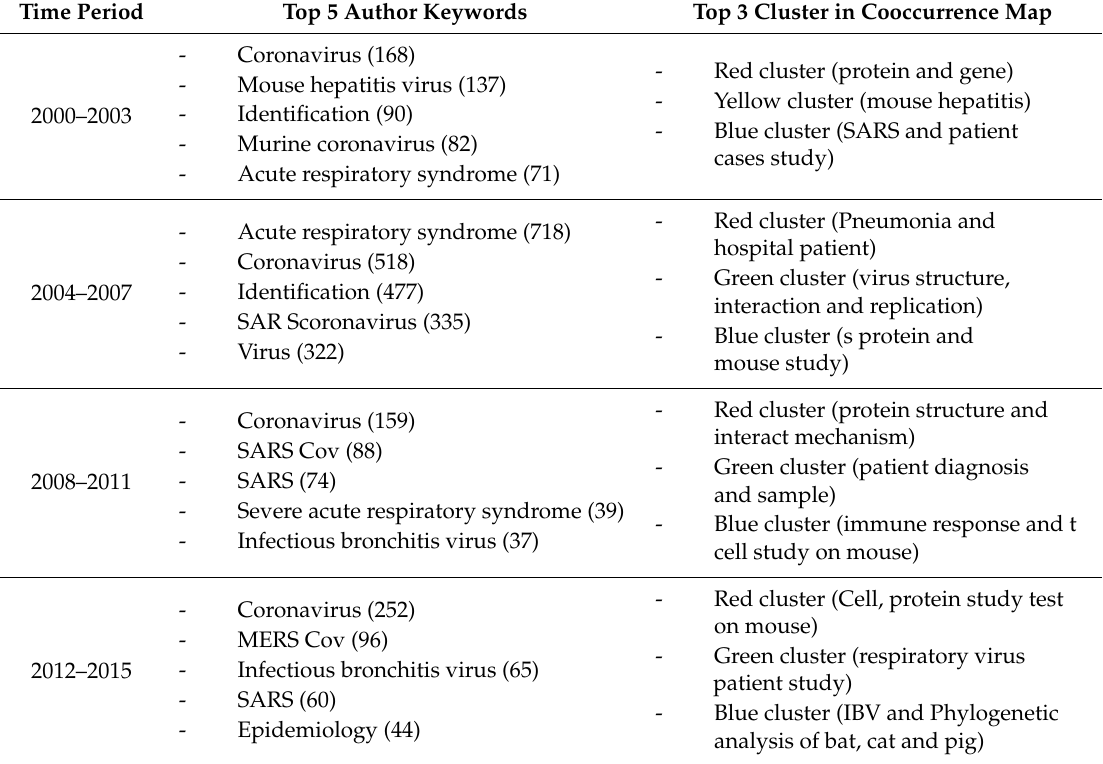
Table 11. Summary of word cloud and co-occurrence maps for five time